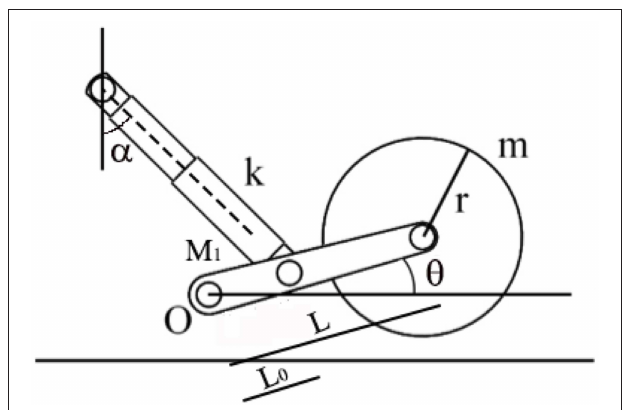
FIGURE 6 | A simple subsystem made by a single-arm linkage with a shock absorber.